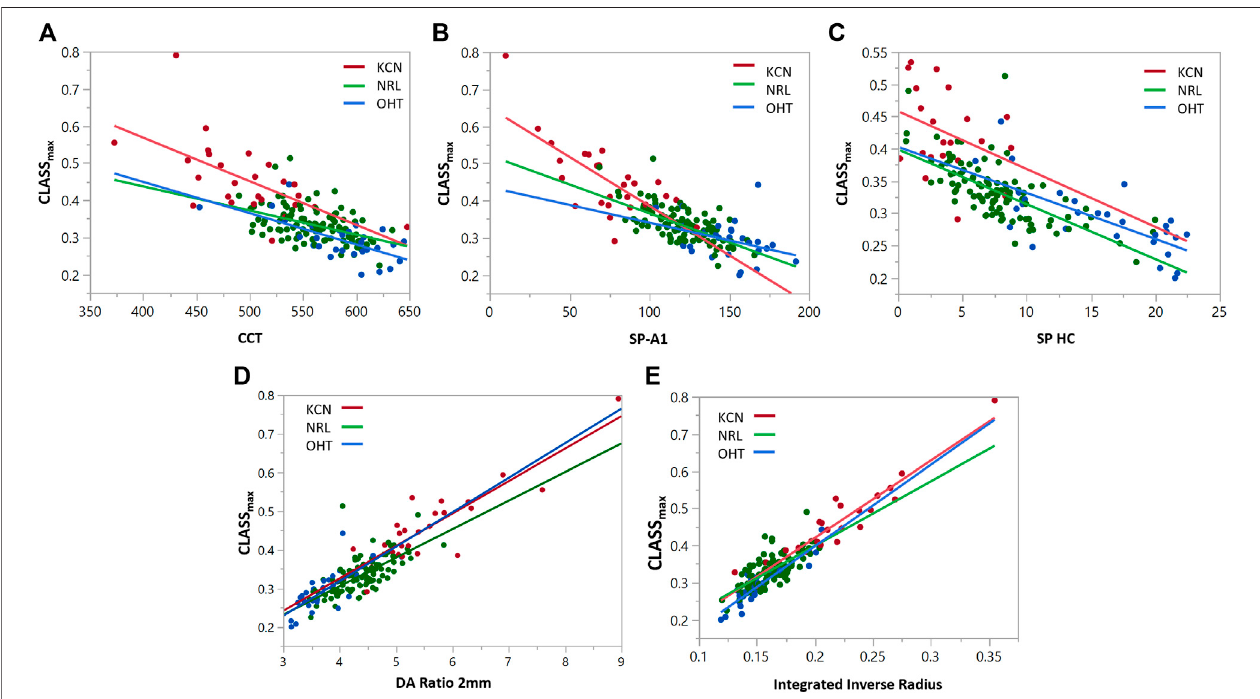
FIGURE 5 | Regression analyses for CLASS max vs. (A) CCT, (B) SP-A1, (C) SP-HC, (D) DA ratio 2 mm, and (E) integrated inverse radius for keratoconic (KCN), normal (NRL), and ocular hypertensive (OHT) subjects.